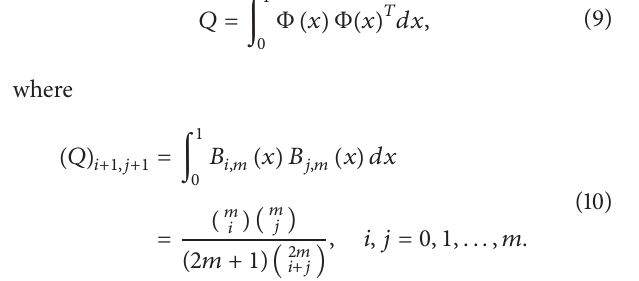
Figure 2: Approximate solutions of 𝑥 2 (𝑡) for 𝑚 = 10 and different values of 𝛼 1 , 𝛼 2 by OMCFD and OMRLFI in Example